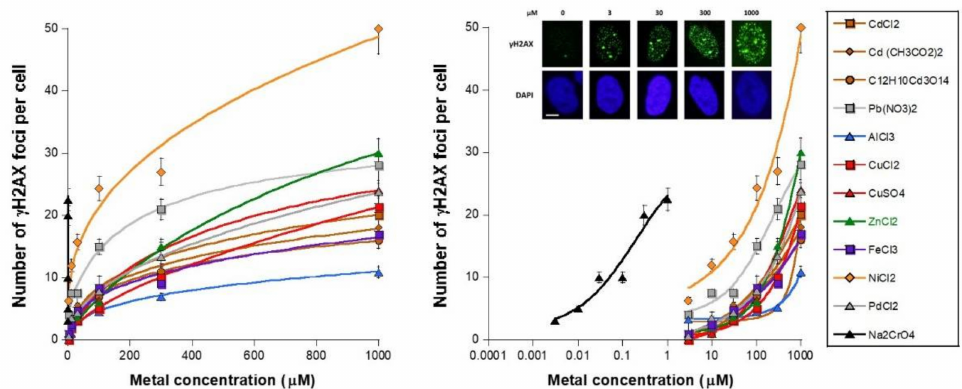
Figure 1. Unrepaired DSB after metal exposure. Number of γ H2AX foci per cell in the human untransformed radioresistant 149BR cells after incubation for 24 h with the indicated concentration of metal species plotted either in a linear scale (left panel) or in a log scale (right panel). Each plot represents the mean ± standard error (SEM) of at least three replicates. Insert: Representative examples of γ H2AX and DAPI-counterstained images obtained at the indicated concentration of CuCl 2 . The white bar represents 5 µ